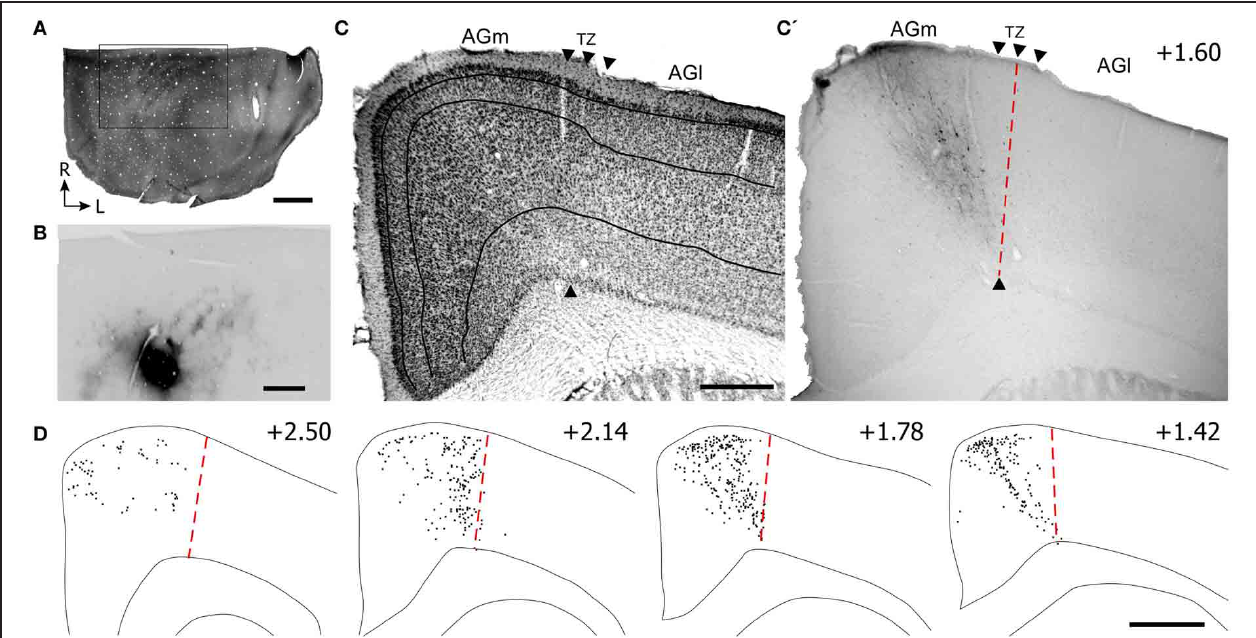
FIGURE 6 | Projections from posterior parietal cortex (PPC) terminate primarily in the caudal part of AGm. (A,B) Adjacent tangential sections showing CO-labeled barrels in SI and the BDA tracer deposit in PPC, which is caudal to SI. Rectangle indicates the magnified image of the PPC injection site and BDA labeling in the SI septa. (C,C (cid:2) ) Adjacent